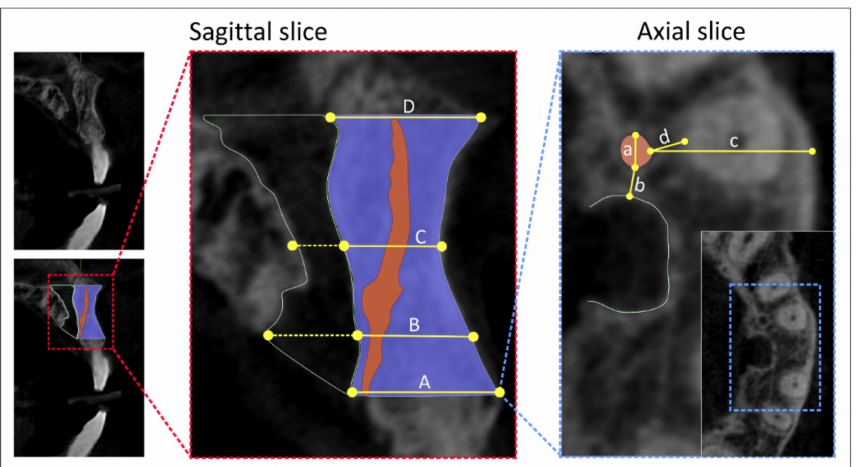
Figure 1. CBCT slices and landmarks of interest. Sagittal cross-section—sagittal CBCT slice ( left , upper ); slice with marked field of interest ( left , bellow ); selected landmarks for analyses ( right )—(A) the distance between the buccal border of incisive foramen and facial aspect of the buccal bone wall, (B) the distance between the buccal wall of the nasopalatine canal and facial aspect of the buccal bone wall using a horizontal line from the palatal border of the incisive foramen, (C) the distance between the buccal border at the midpoint level of NPC length and facial aspect of the buccal bone wall, (D) the distance between the buccal border of nasal foramen and facial aspect of the buccal bone wall; Axial cross-section—axial CBCT slice ( right ); (a) the diameter of AC, (b) the distance between AC and NPC, (c) the distance between AC and facial aspect of the buccal bone wall, (d) the distance between AC and central incisor